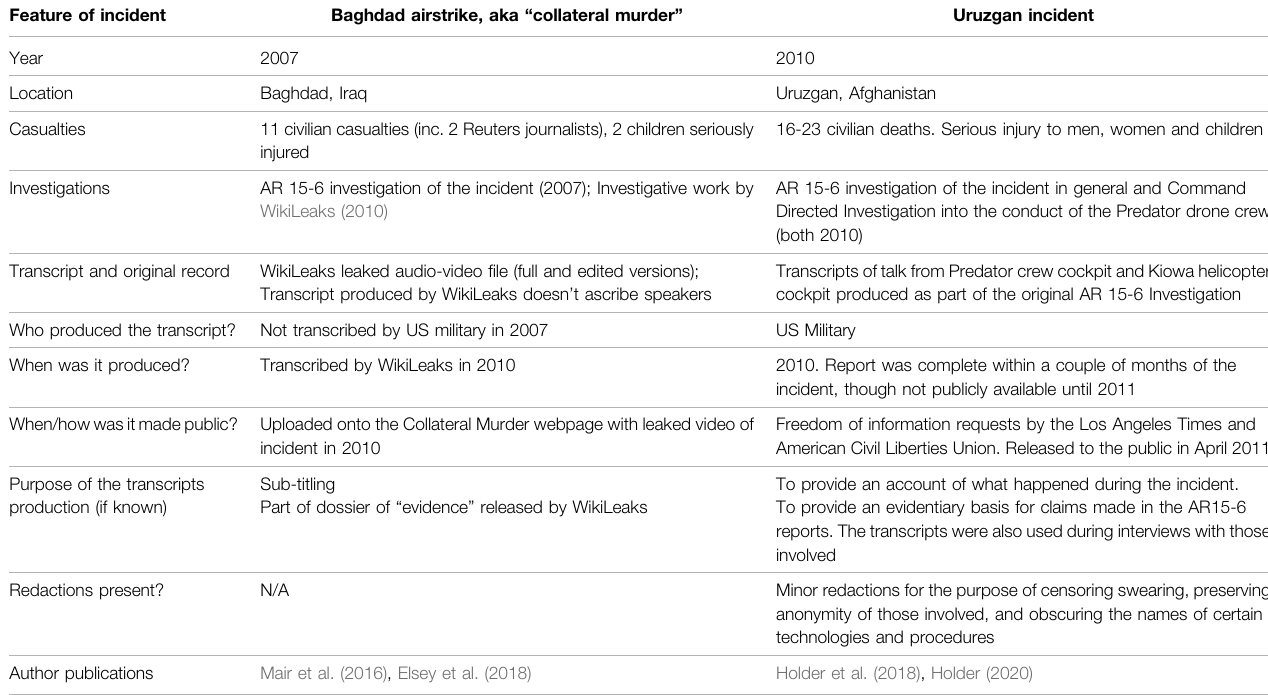
TABLE 1 | Key features of two incidents involving US Military. Feature of